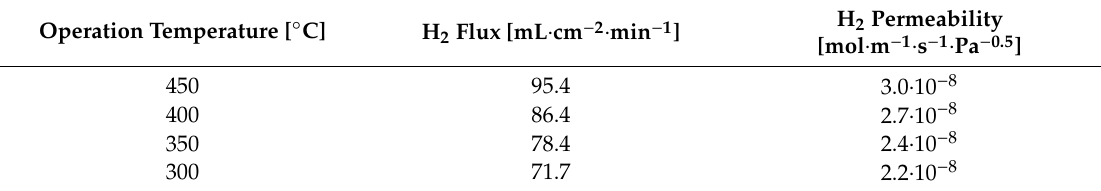
Table 1. Hydrogen flux and permeability as a function of operation temperature. A membrane thickness of 10 µ m was used to calculate the permeability.